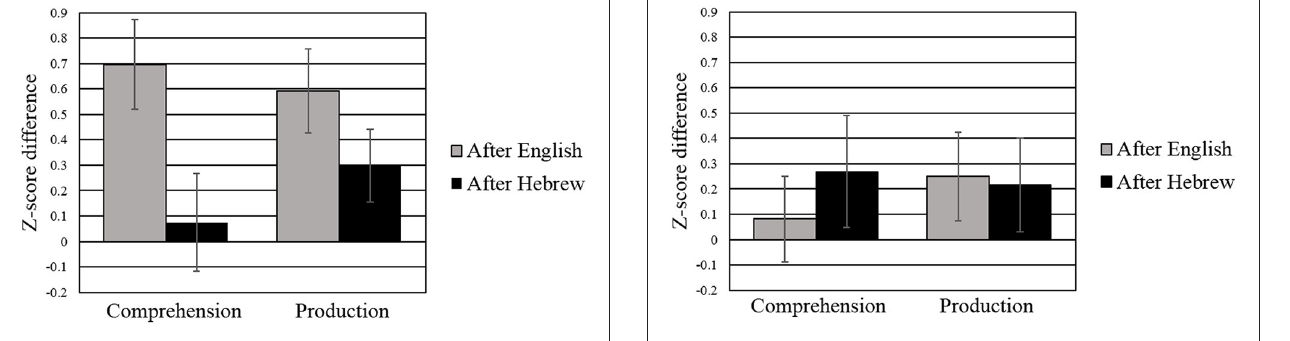
FIGURE 2 | Pre and post z -scores in the letter fluency task (error bars represent standard error).